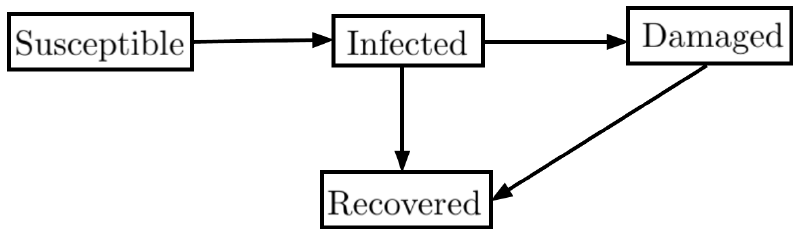
Figure 2. Flow diagram representing the dynamics of the SIDR